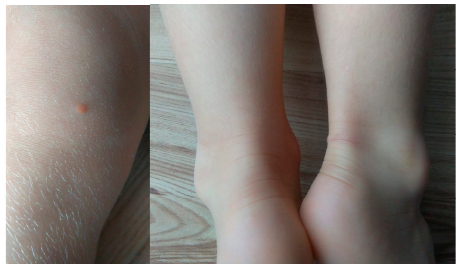
Figure 3. Xanthoma found on right knee. A similar-size xanthoma on the right Achilles tendon was removed.